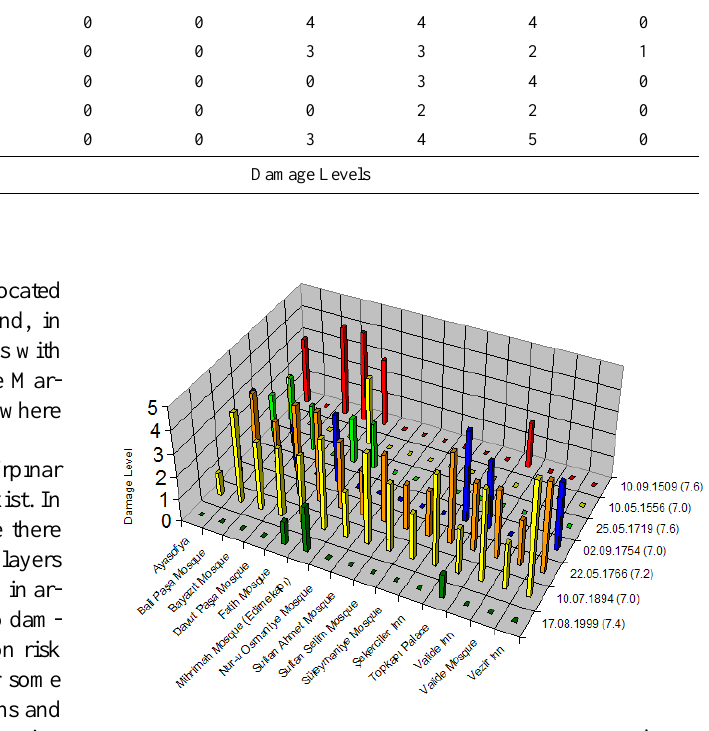
Figure 15. Comparison of damage levels in various earthquakes and Ground shaking microzonation map prepared for probability of exceedance of 10% in 50 years. ( İ nce, 2005) 9